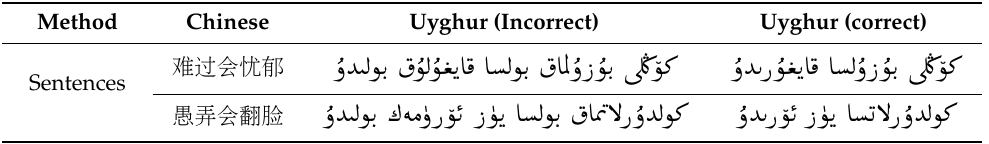
Table 4. Failed Uyghur sentences generation example for Causes relation. Table 3. Failed Uyghur sentences generation example for Causes relation.